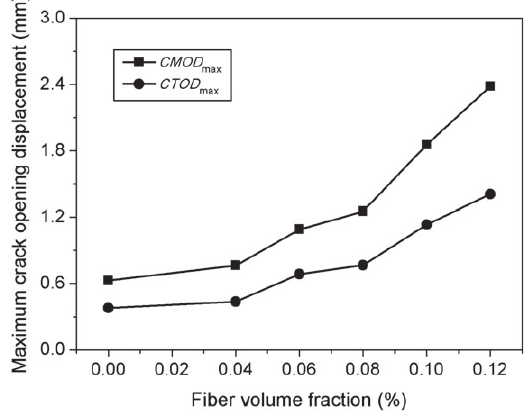
Figure 10 Effect of the polypropylene fiber on the CMOD CTOD . max